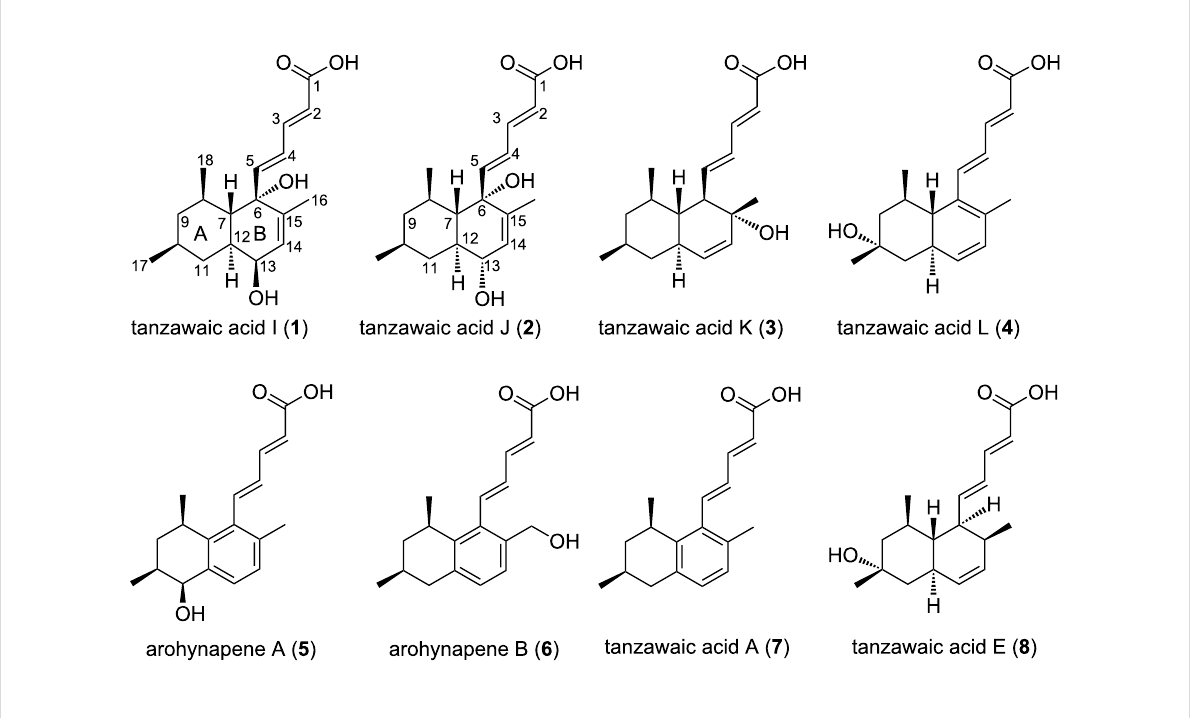
Figure 5: Structures of the isolated compounds.